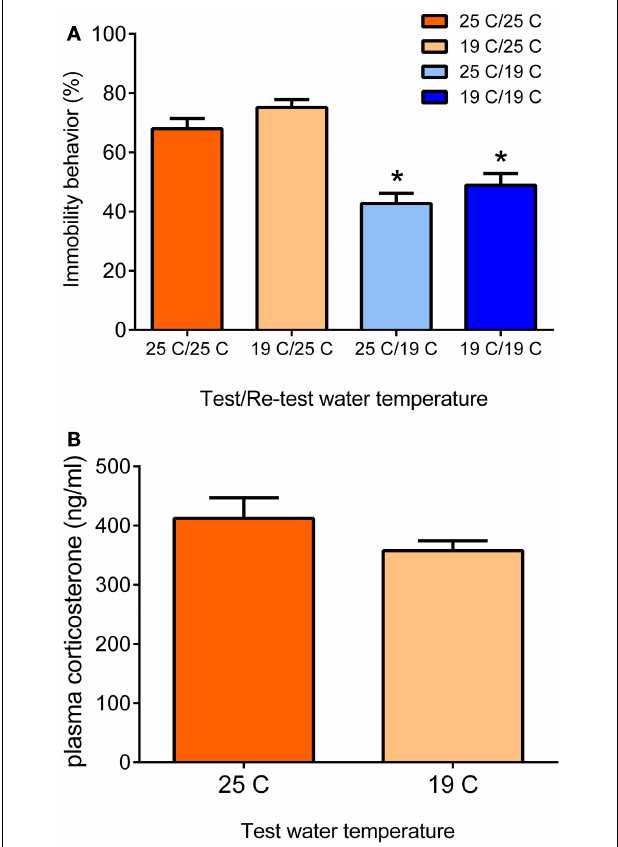
FIGURE 1 | Behavioral immobility response in the re-test depends on the water temperature during the re-test (A) . MaleWistar rats were forced to swim for 15min in 19 or 25°C-water (test).Twenty four hours later, they were forced to swim again for 5min in 19 or 25°C-water (re-test).The data are presented as mean percentage immobility behavior during the 5-min re-test procedure ± standard error of the mean (SEM; n = 11–15) of different test/re-test water temperature conditions (see x -axis and legend). The data show that the immobility response in the re-test depends on the water temperature during the re-test and is independent of the water temperature at the time of the initial 15-min test. At 25°C re-test water temperature, the rats present the typical immobility response irrespective of the water temperature during the initial test. At 19°C re-test water temperature, the animals show significantly lower immobility scores, also irrespective of the water temperature during the initial test.Thus, in the Re-test, rats choose a behavioral strategy to cope with a challenge depending on conditions at the time of the challenge.The differential behavioral responses were not due to different responses in plasma glucocorticoid hormone (B) . MaleWistar rats were forced to swim for 15min in 19 or 25°C-water and killed at 30min after start of the forced swim procedure. Data are expressed as mean plasma hormone levels ± SEM (nanogram/milliliter; n = 9). Statistical analysis: (A) Two-way ANOVA: effect of test water temperature: F (1,49) = 3.718, P = 0.06 [Thus, there was a trend that if rats had swum at 19°C in the test, they would show a slightly higher immobility response in the re-test (see also Ref. (18)]. Effect of re-test water temperature: F (1,49) = 55.163, P < 0.0005.The interaction term was not statistically significant. (B) Student’s t -test: P > 0.05, not significant. Johannes M. H. M. Reul and Sabine Ulbricht conducted this study at the Max Planck Institute of Psychiatry in Munich, Germany, unpublished